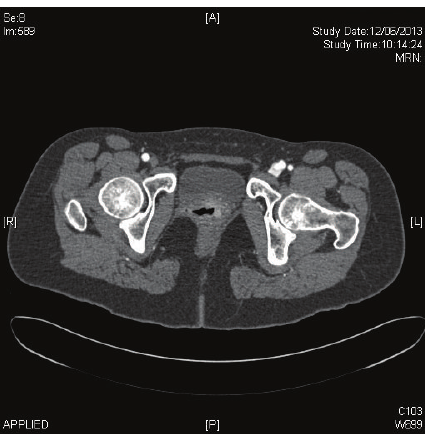
Figure 1: A CT angiogram demonstrating the abnormal contrast flow between the SFA and CFV, diagnosing the arteriovenous fistula.